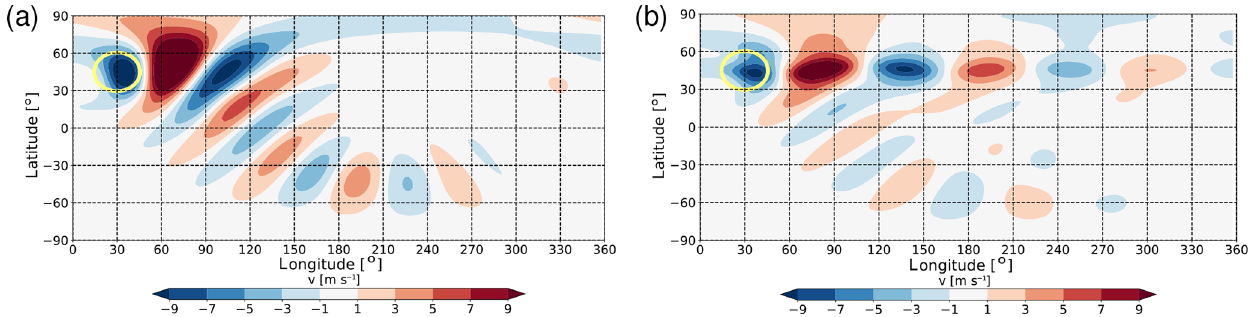
Figure 3. Illustration of the numerical solution for an initial state with (a) pure solid-body rotation and (b) a strong narrow jet superimposed on solid-body rotation. Displayed in both cases is the time-averaged meridional wind v . The oval-shaped yellow contour is the contour of the orography h(λ , φ) at 0.3 h 0